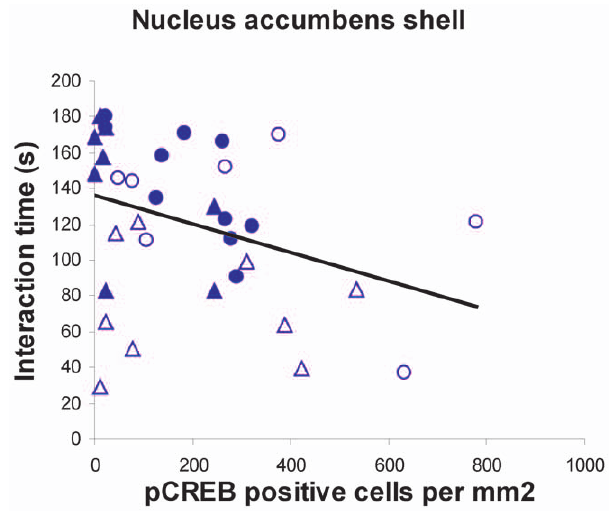
Figure 5. Correlation between pCREB positive cells in NAc shell and interaction time with a novel target mouse. Filled circles (control males), open circles (stressed males), filled triangles (control females), open triangles (stressed females). Spearman r = 2 0.37,